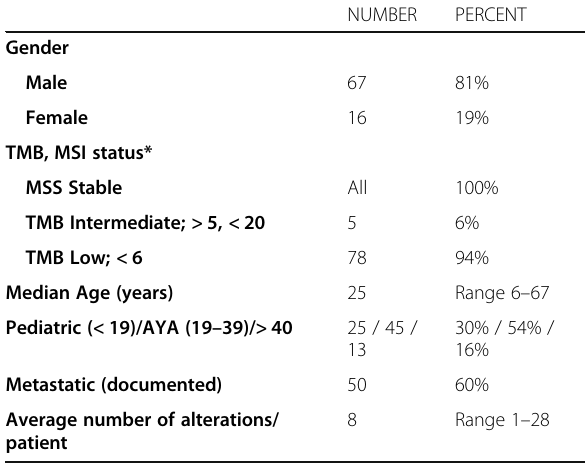
Table 1 Demographics of 83 patient cohort